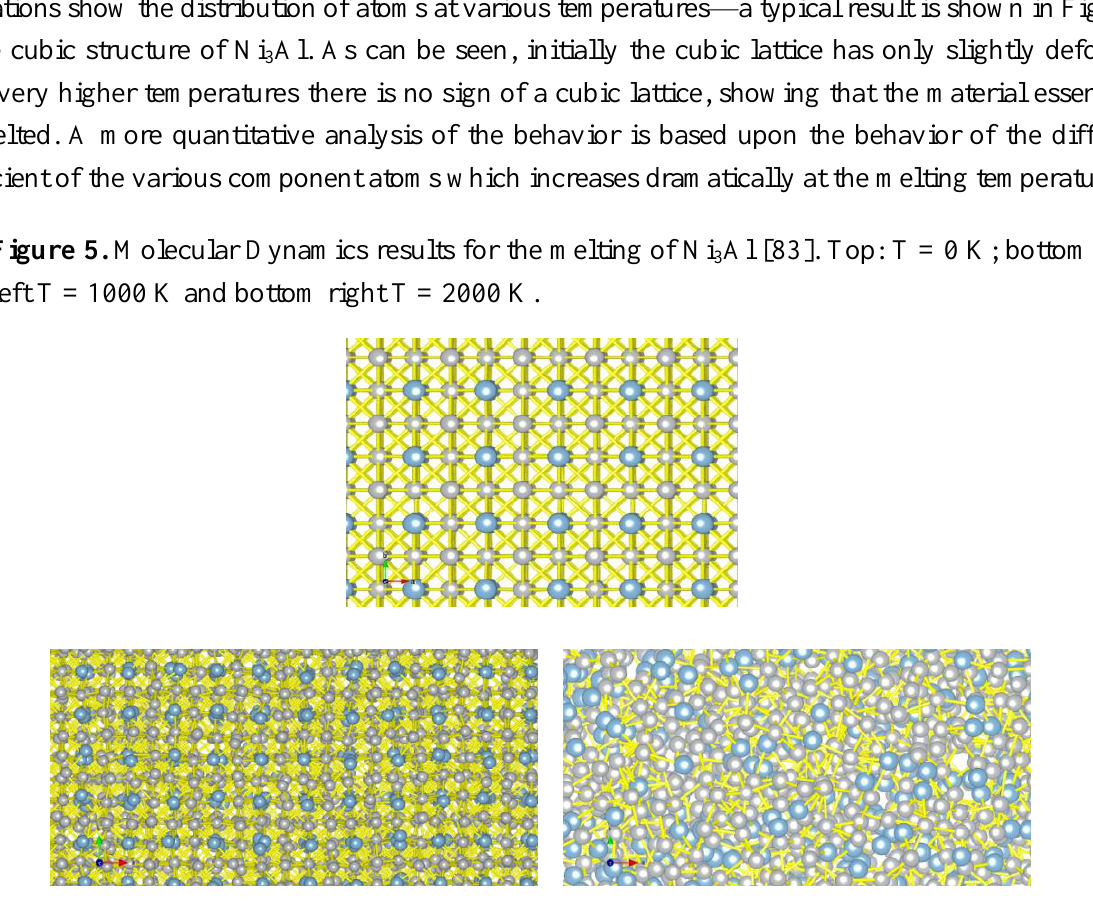
Al [83]. Top: T = 0 K; bottom 3